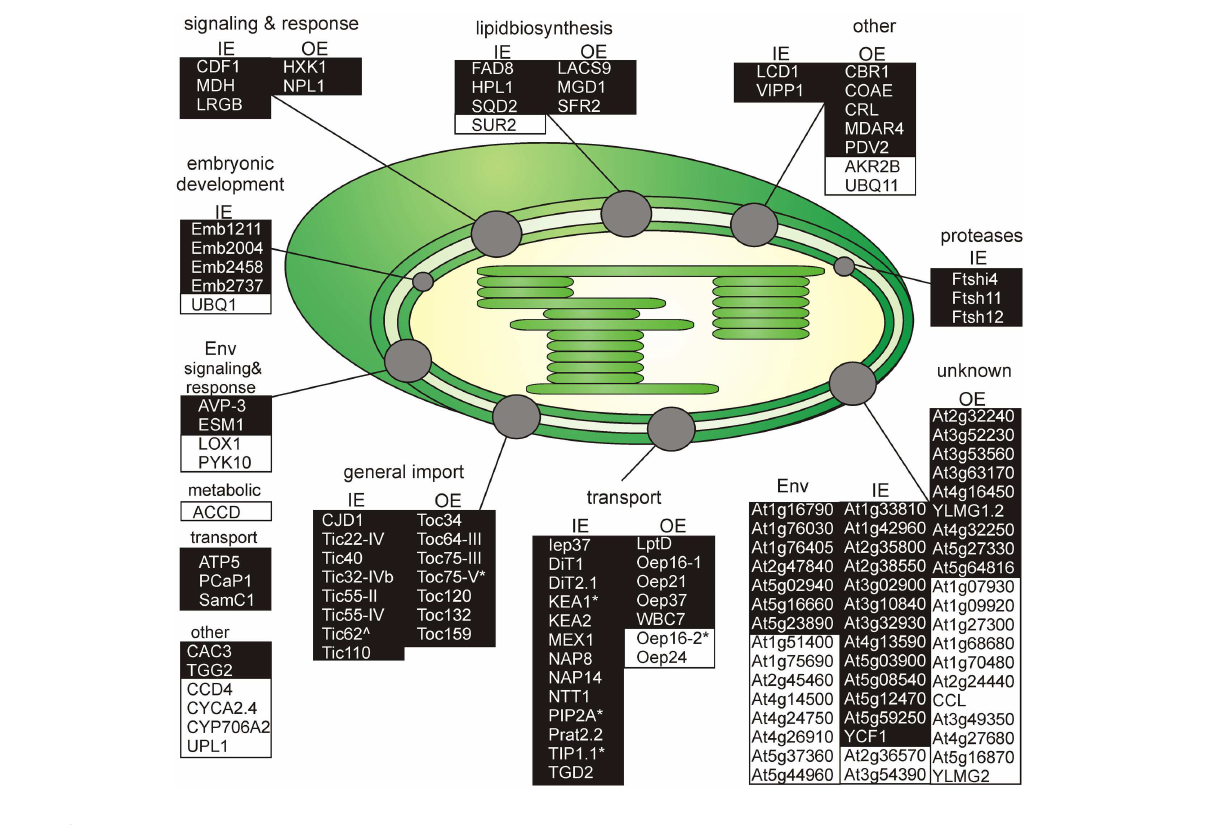
FIGURE 3 | Functional categorization of detected outer or inner envelope proteins. Shown are all proteins clustered by their known functions ( Tables 3 – 5 ).The proteins of each cluster are sorted by the localization in the inner (IE) or in the outer envelope (OE) fraction. Proteins with an unclear localization (ENV) are listed in a separated cluster. Also